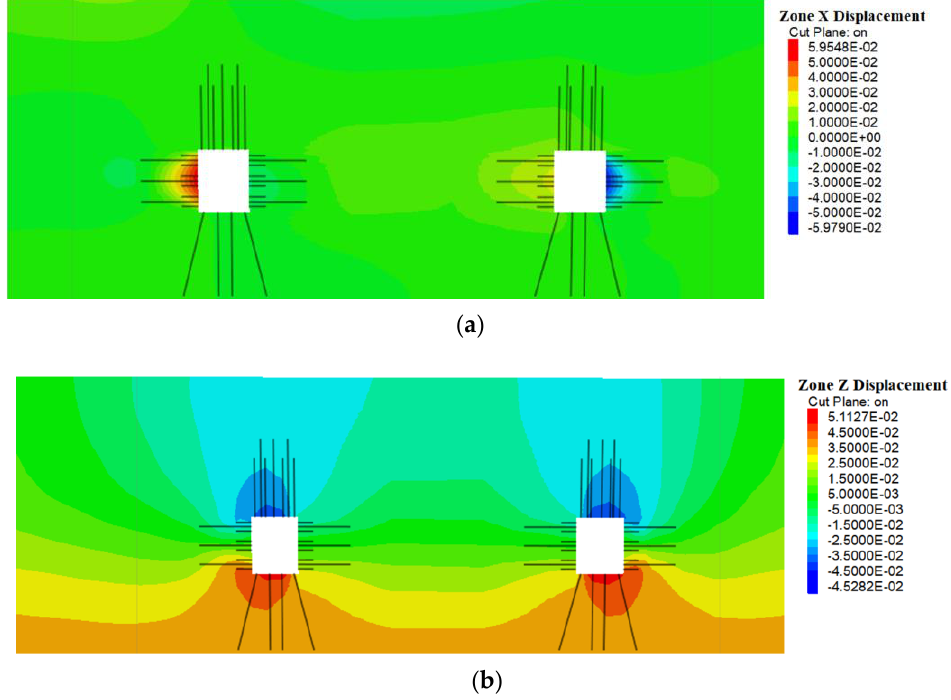
Figure 15. Displacement cloud chart of LBG control technology. ( a ) A horizontal displacement cloud chart of LBG control technology; and ( b ) a vertical displacement cloud chart of LBG control technology.